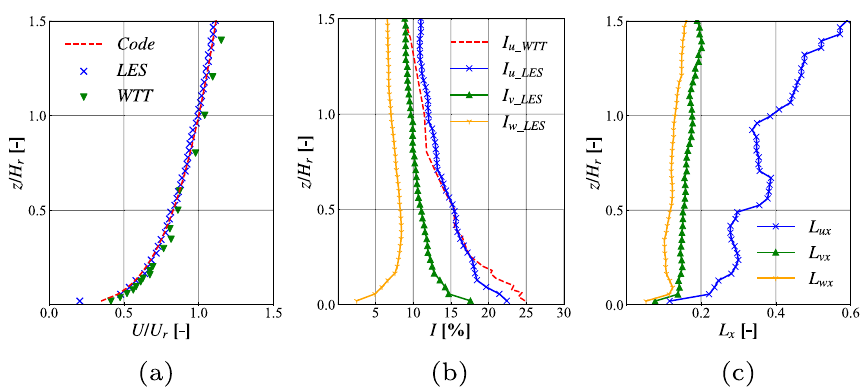
Fig. 3 The turbulence characteristics of the wind fields in WTT and LES: ( a ) mean wind speed, ( b ) turbulence intensities and ( c ) integral length scales